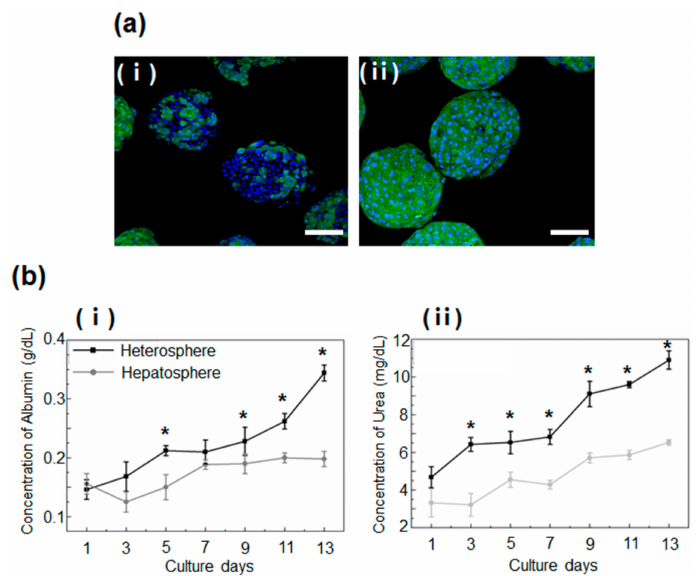
Figure 4. ( a ) Immunostaining for serum albumin (green) in the ( i ) hepatospheres and ( ii ) heterospheres cultured for 2 weeks. The nuclei were stained with DAPI (blue). Scale bar = 100 µ m. ( b ) Analysis of the function of heterospheres and hepatospheres, measured in terms of the secretion of ( i ) albumin and ( ii ) urea. Data are represented as the mean ± standard deviation (SD) of five independent experiments. * p < 0.05 for hepatosphere vs. heterosphere.